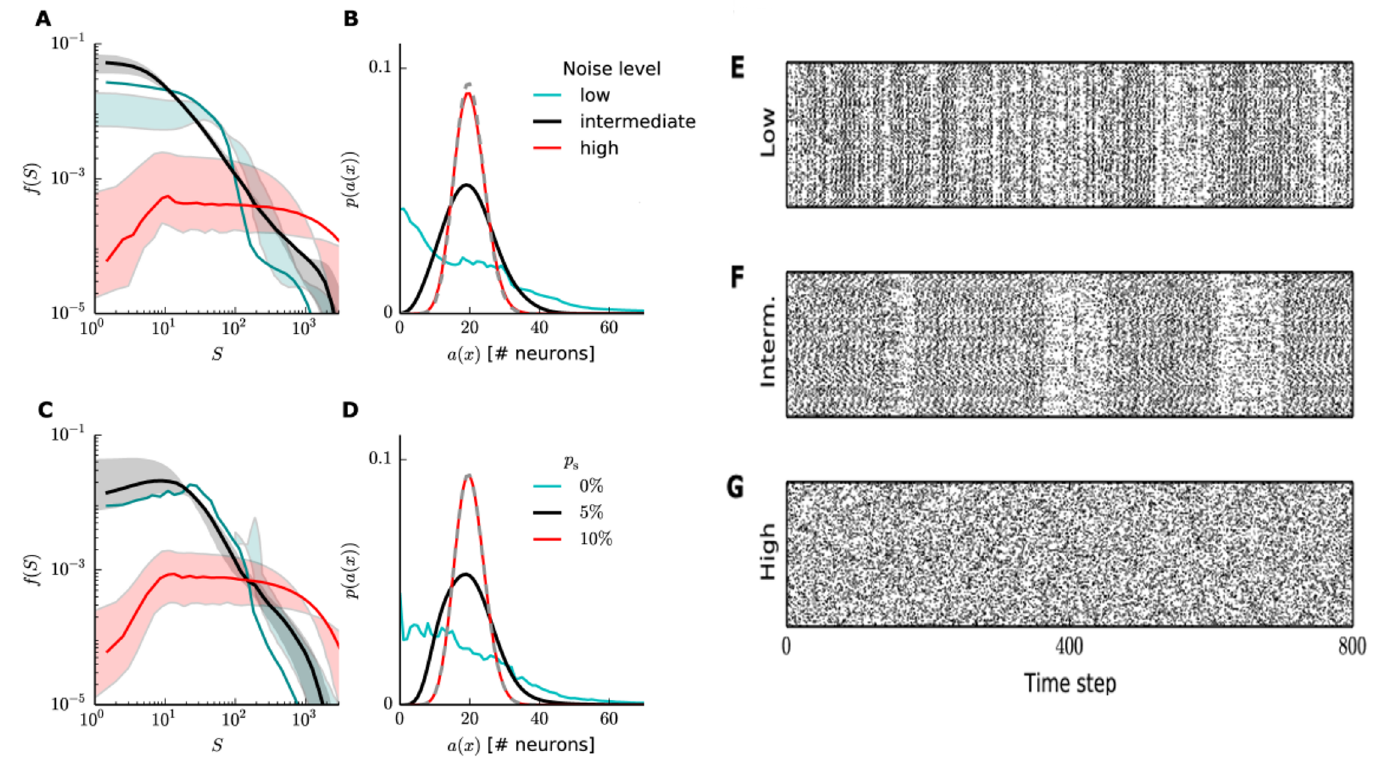
Fig 5. Noise level influences the SORN dynamical regime. Left, top row: avalanches’ size (A) and activity (B) distributions for SORN with different Gaussiannoise levels: low ( σ 2 = 0.005), intermediate( σ 2 = 0.05) and high ( σ 2 = 5). Very weak or strong noise levels break down the power-laws, suggestinga different non-critical regime. Left, bottom row: Avalanches’ size (C) and activity (D) distributionsfor the random spike noise source (see text), showinga similar effect. Gray dashedlines are binomial distributions( n = N E = 200, p = μ IP = 0.1), the theoreticalprediction for independentneurons,and shaded areas show the effects of variations in the activity threshold( θ betweenthe 5th and 25th percentiles of the activity distribution). All curves show combineddata of 50 independentsimulations. (E), (F), (G) Typical raster plots of excitatory unit activity at low, intermediate and high Gaussiannoise levels, respectively,for N E =